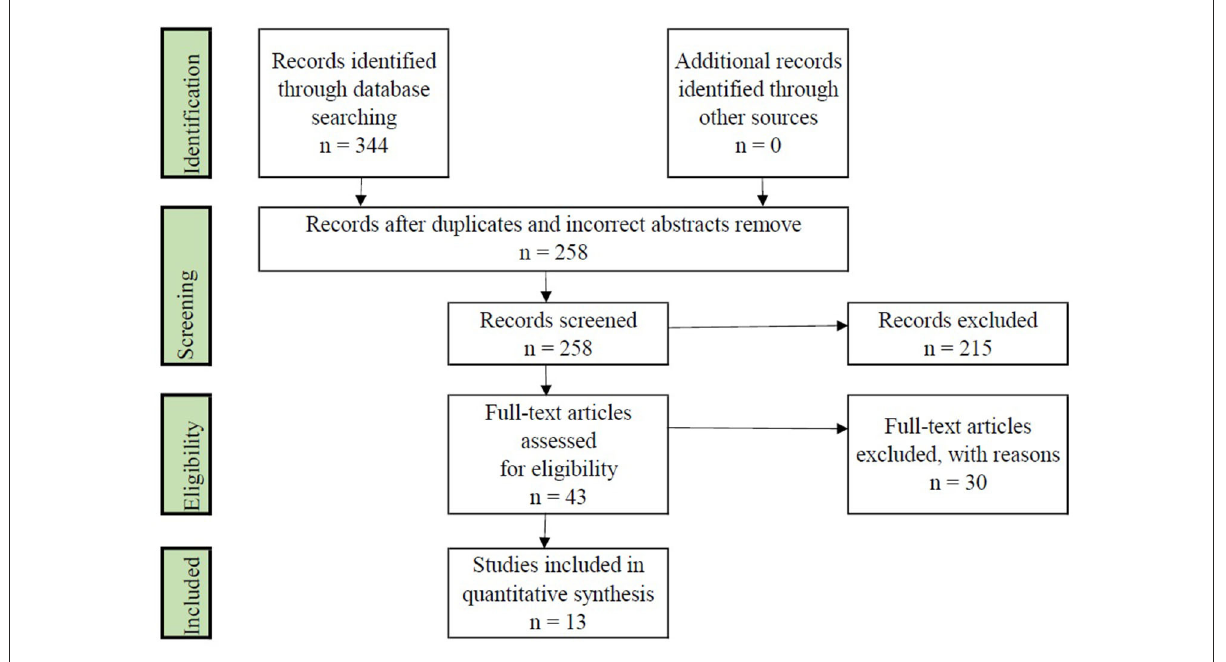
FIGURE1 Selection process of the studies.